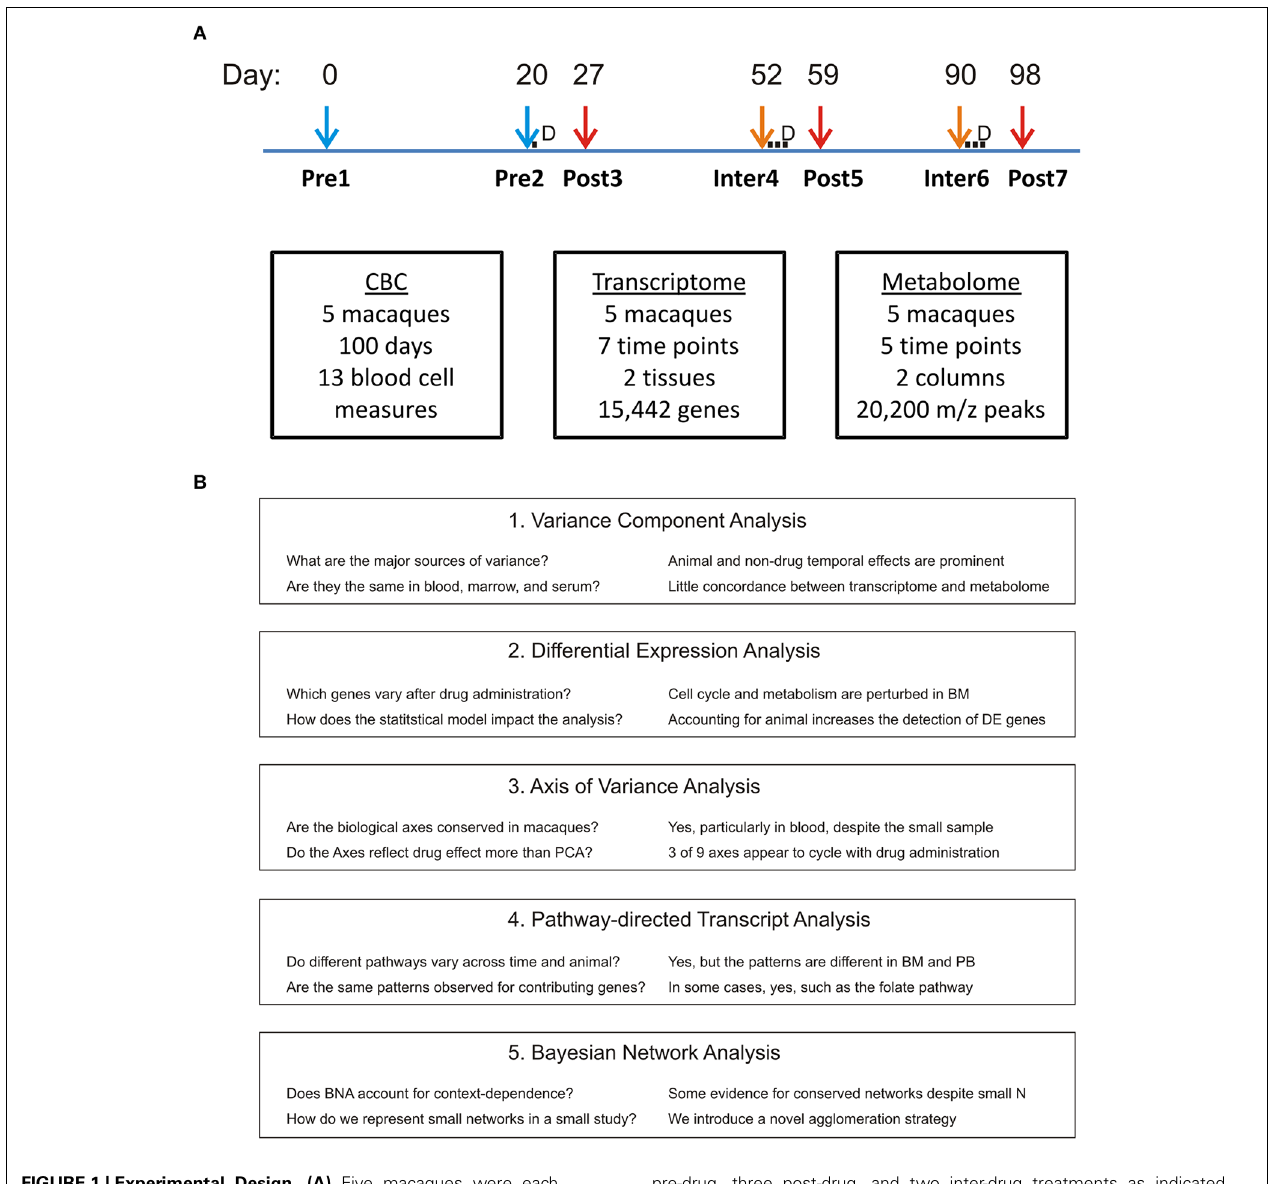
pre-drug, three post-drug, and two inter-drug treatments as indicated. Metabolome data was not generated for the first two timepoints. (B) Flow of analytical approaches including major questions asked and inferences